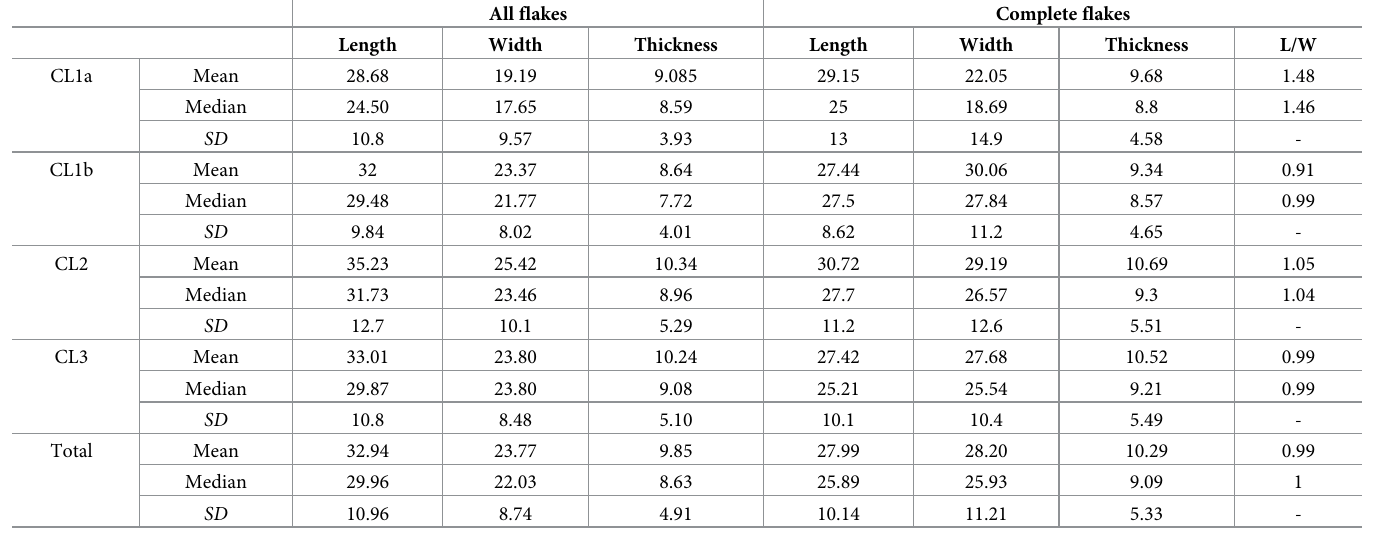
other words, blank production across the CFAs shows a clear similarity in flake length and width, with little sign of narrow and elongated flakes. Additionally, retouched tools are signifi- cantly longer ( U = 31423, p < .005) and wider ( U = 37406, p < .005) than blanks but not thicker ( U = -4.1, p = .029) throughout all assemblages. Except for the CL1a again (Fig 4), the difference in the size of retouched tools and blanks is not as clear. In summary, there appears to be a consistent blank production pattern at SDG2, aiming toward the production of rela- tively broad blanks and prominently larger sized tools. Platform and preparation. Here, we focused on the blanks and tools with platform pre- served. In general, there is a lack of platform preparation in CFAs at SDG2. For flakes with platform preserved (N = 1013), the majority of the flakes and tools are characterized by plain platforms, followed by cortical, and with a small portion of crushed, punctiform, linear, dihe- dral, and facetted types (Table 5), as well as two other undetermined types. For blanks, the Table 3. Measurements of blanks